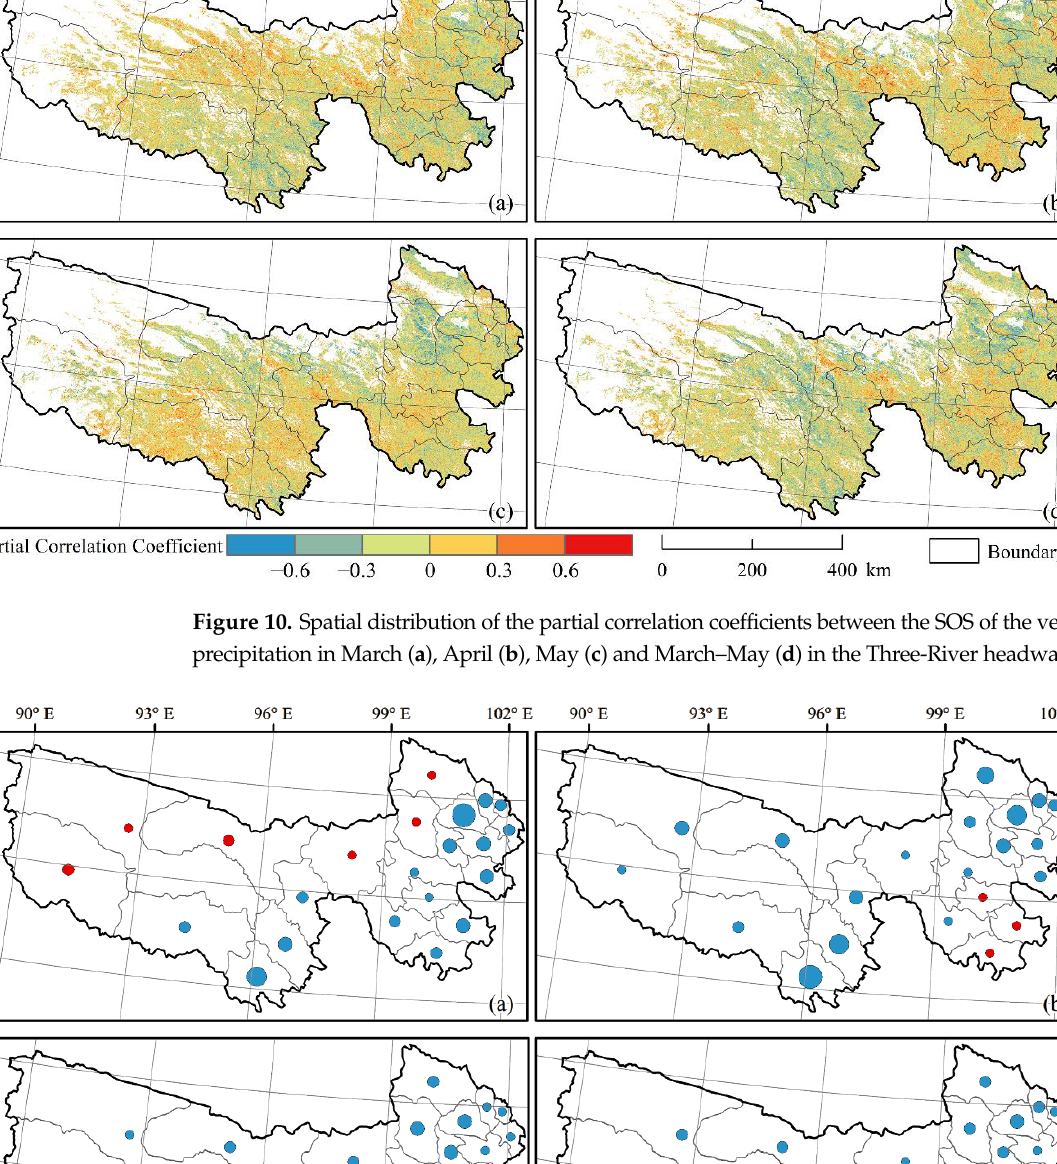
Figure 9. Spatial distribution of the sensitivity coefficients between the SOS of the vegetation and air temperature in March ( a ), April ( b ), May ( c ) and March – May ( d ) in the Three-River headwaters region.